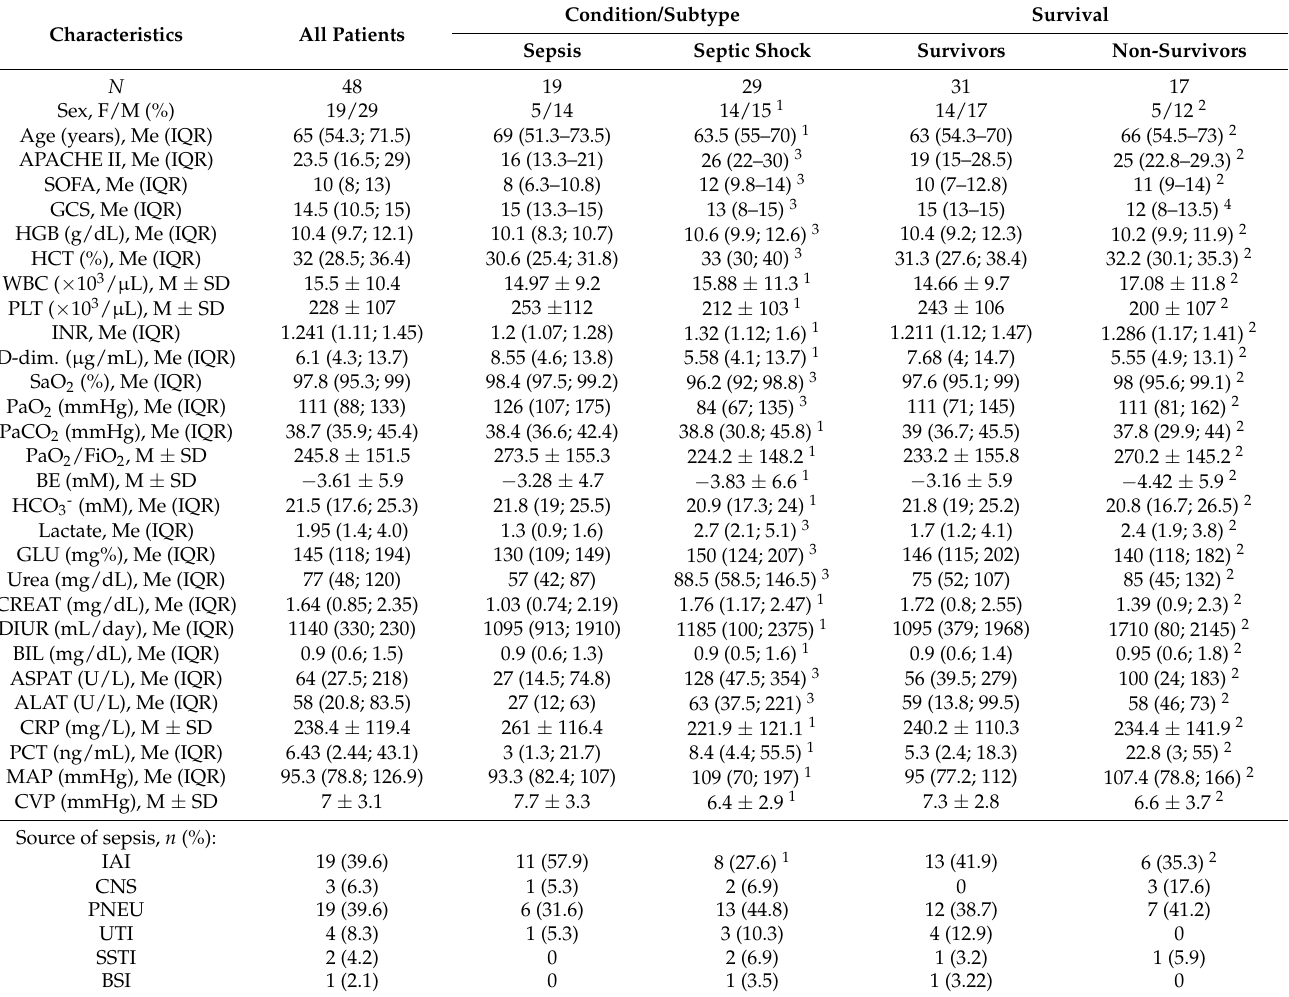
Figure 1. STROBE flow chart of the study participants. Table 1. Characteristics of study population.